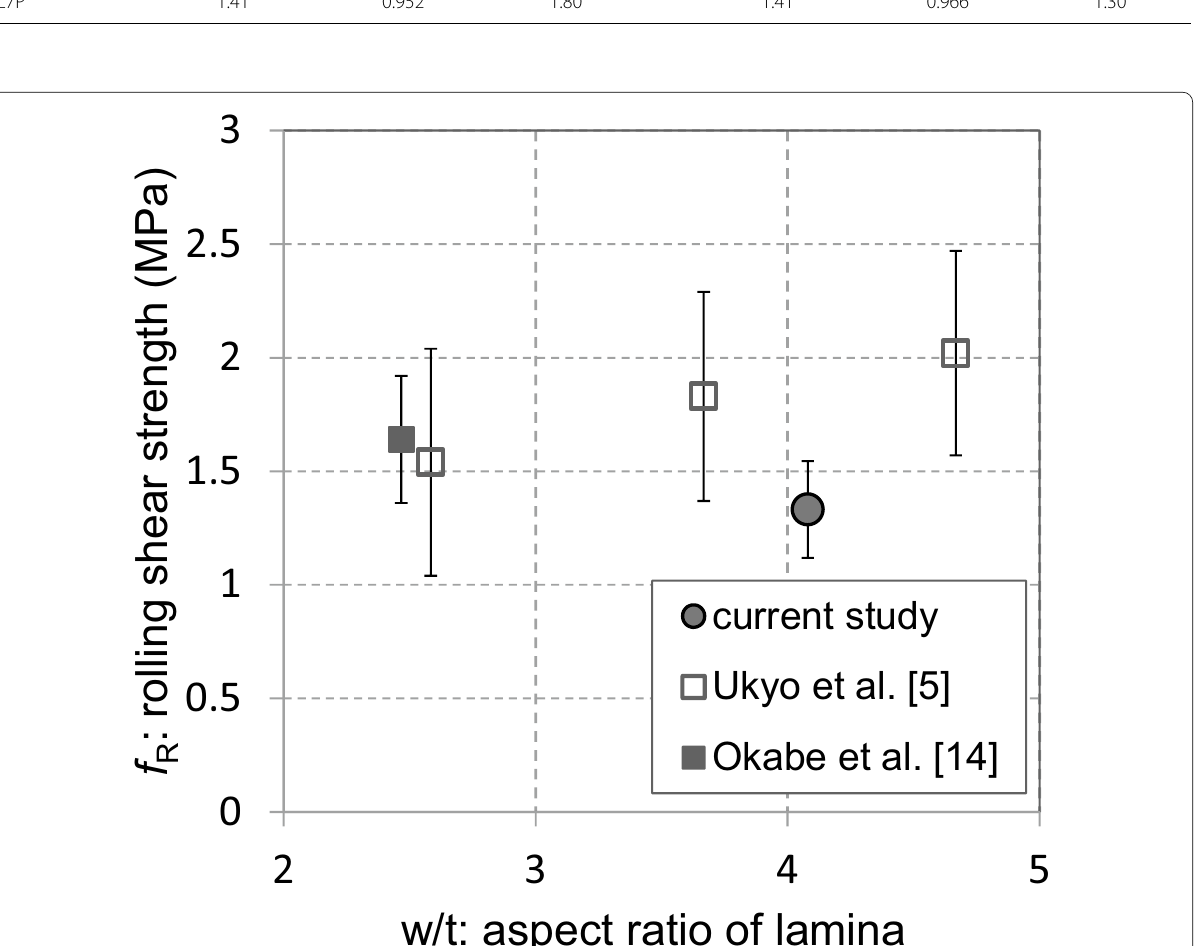
Fig. 14 Comparison of rolling shear strength of sugi (Japanese cedar) obtained in the current study and in previous studies. Error bars for data points of previous studies indicate standard deviation. The error bar of the current study indicates root of mean squared error of the linear regression in Fig.